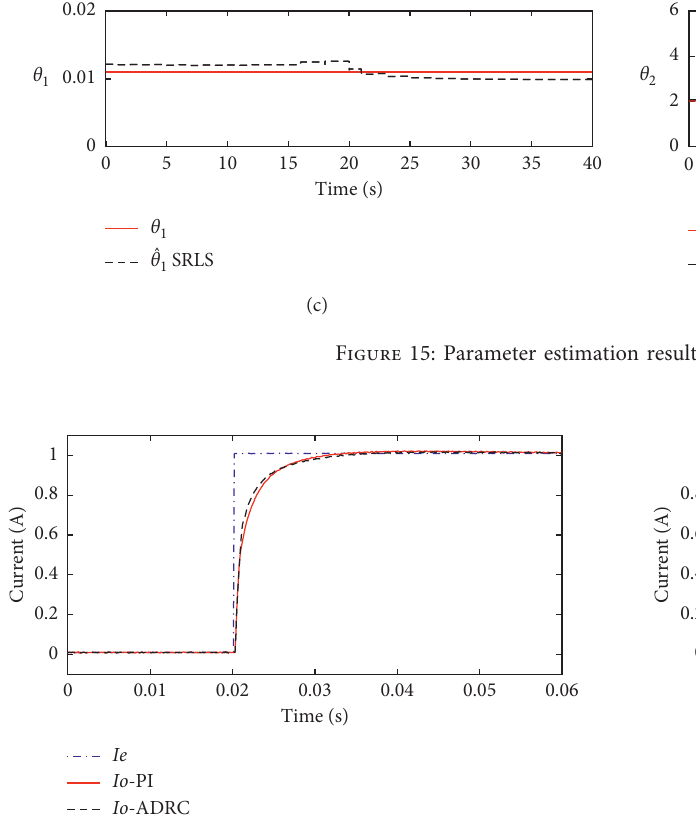
Figure 18: The results comparisons between ADRC and TD- ADRC under step input 1 A.